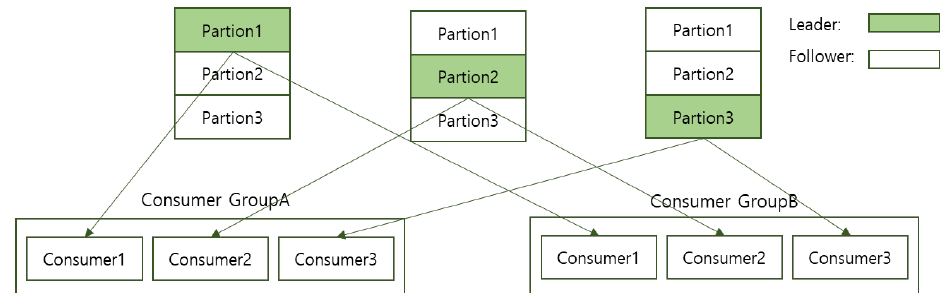
Figure 6. Method of large data streaming in KAFKA.